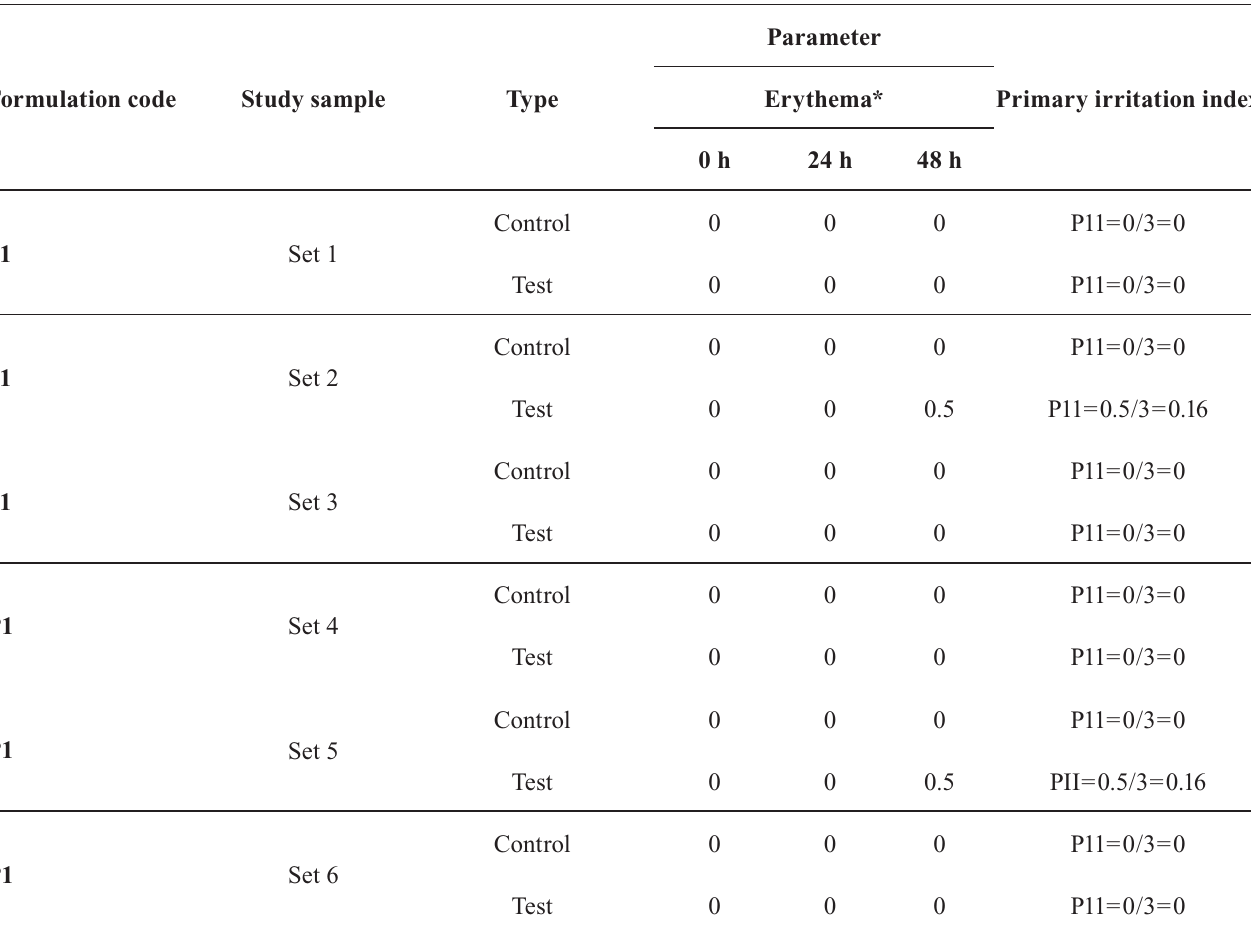
TABLE VII - Results of skin irritation study